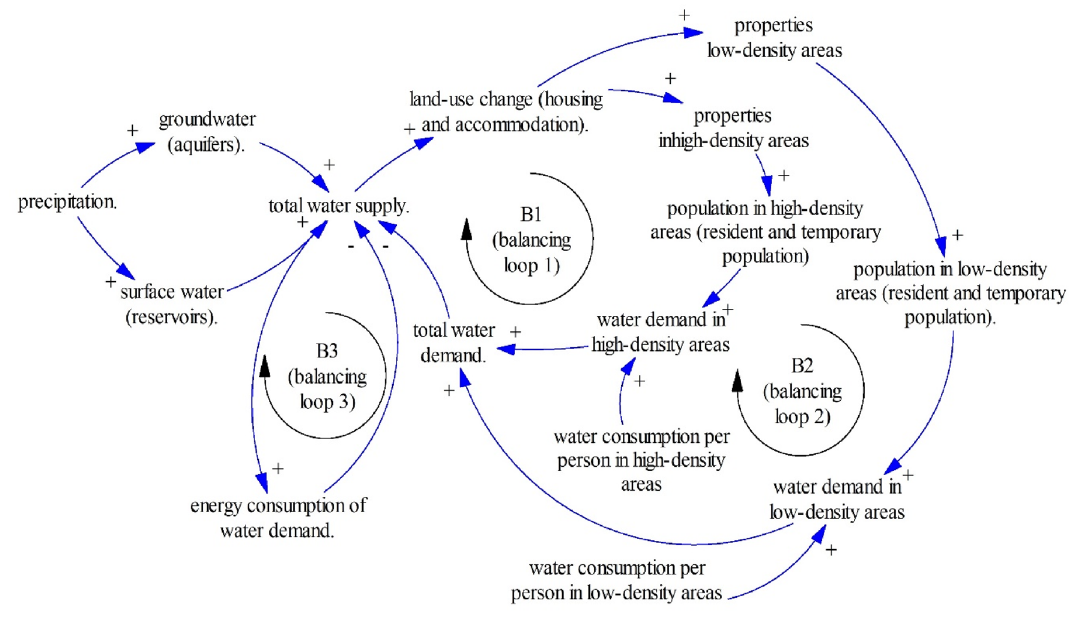
Figure 6. A simplified node of nexus elements in the Marina Baixa County 44